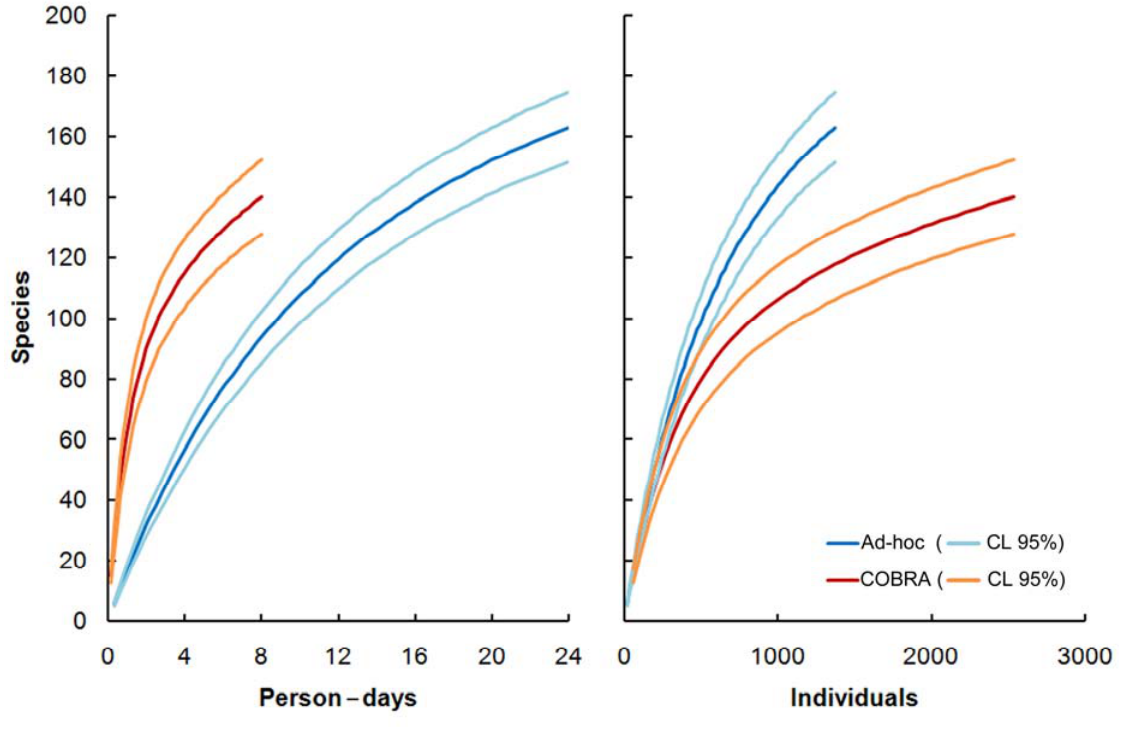
Figure 1. Randomized accumulation curves and respective confidence limits for the species richness obtained by the ad-hoc and COBRA approaches. Curves are drawn either with person-days or individuals as measures of